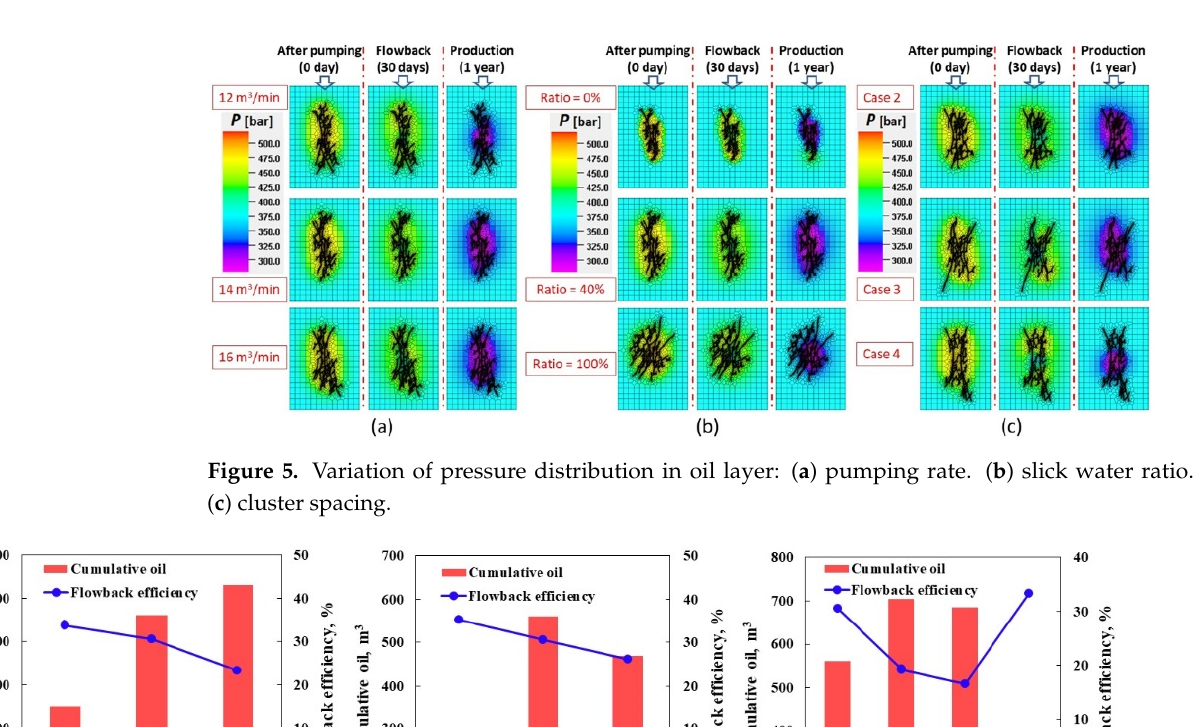
Figure 5. Variation of pressure distribution in oil layer: ( a ) pumping rate. ( b ) slick water ratio. ( c ) cluster spacing.